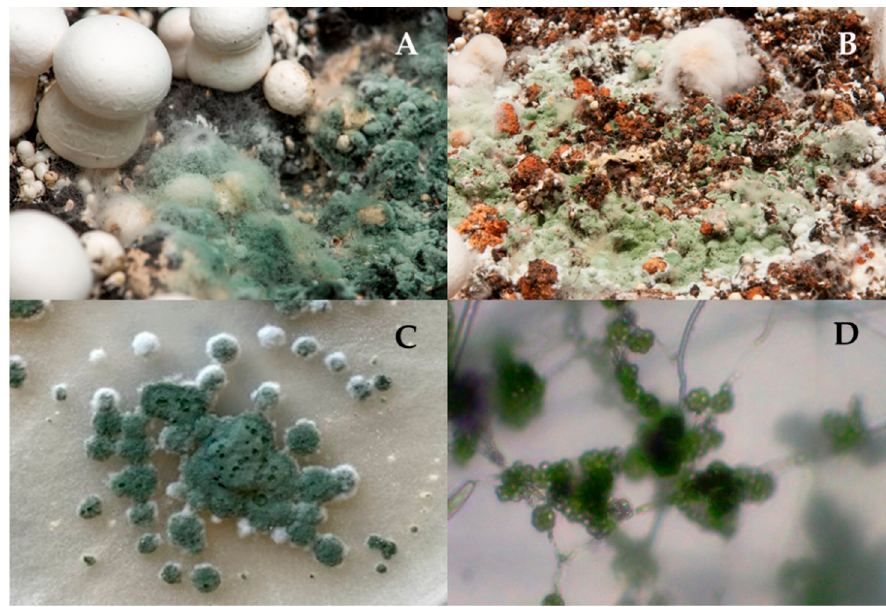
Figure 1. Green mould on the casing layer and mushroom ( A , B ). Isolate of T. aggressivum f. euro- paeum TAET1: Culture ( C ) and conidiophores ( D ). TAET1: Culture ( C ) and conidiophores ( D